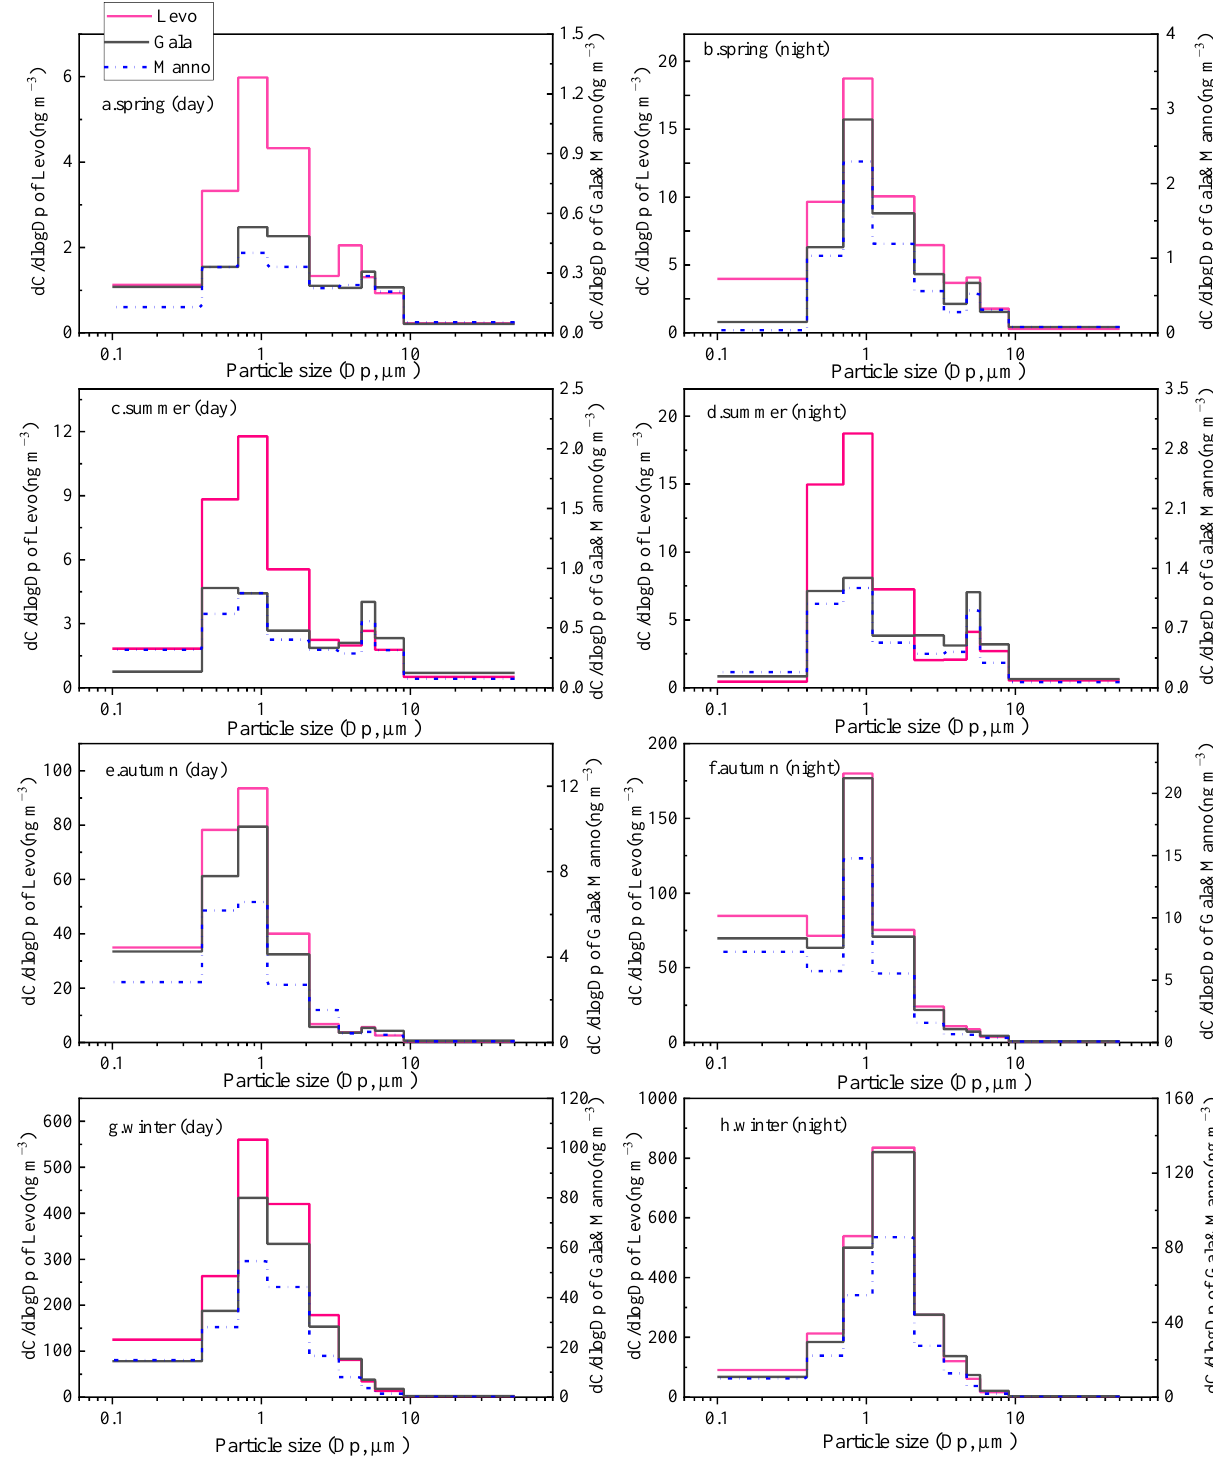
Figure 5. Seasonal particle size distributions of dehydrated anhydrides ( a ). spring day; ( b ). spring night; ( c ). summer day; ( d ). summer night; ( e ). autumn day; ( f ). autumn night; ( g ). winter day; ( h ). winter night.